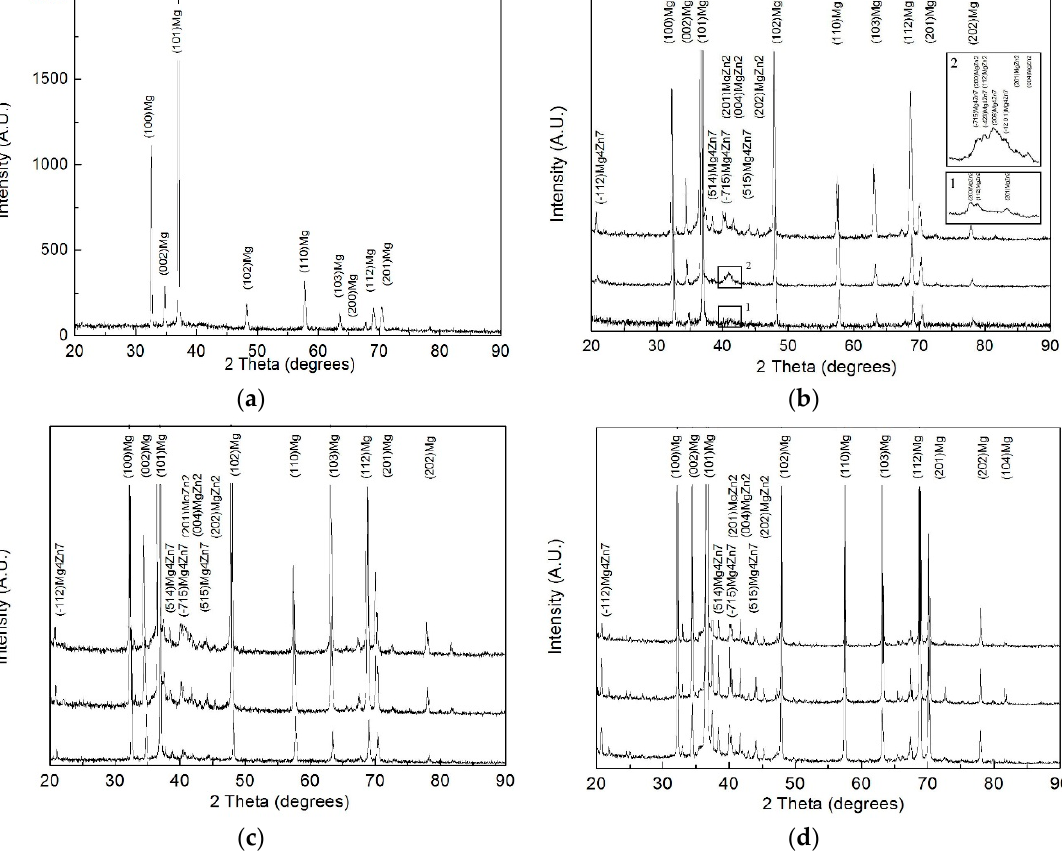
Figure 4. X-ray diffraction (XRD) patterns of Mg-6Zn: ( a ) as-extruded, and ECAP at ( b ) 160 °C, ( c ) 200 °C, and ( d ) 240 °C.